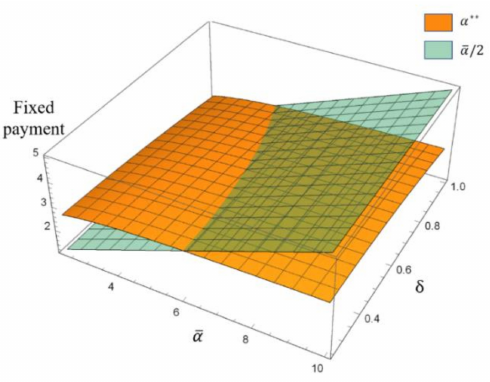
Figure 4. The e ff ects of the highest fixed payment α and the unit subsidy δ on the fixed payment α ∗∗ .